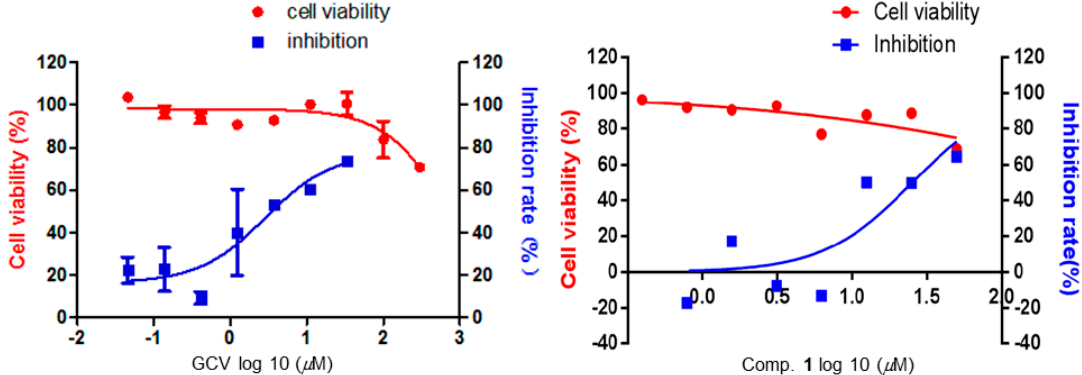
Figure 4. Effects on B95-8 cells viabilities and inhibition on lytic EBV replication of compound 1 was measured using GCV as positive control in vitro. B95-8 cells (5 × 10 5 /well) were cultivated with